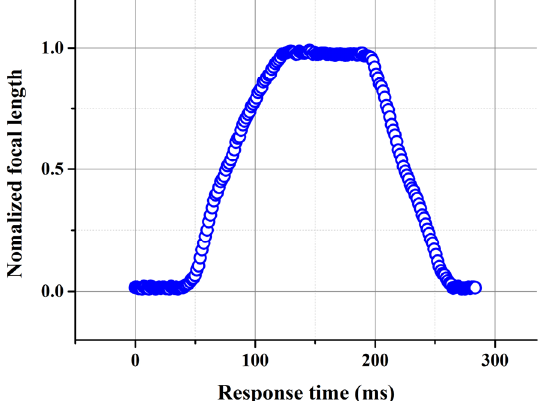
Figure 6. Response time of the device ( U = 65 V).